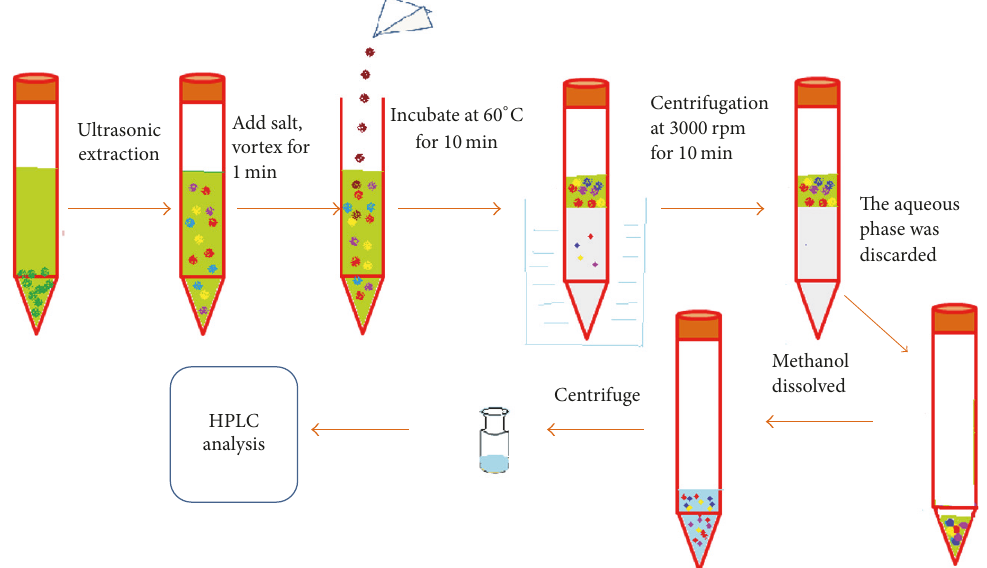
Figure 2: Schematic diagram for micellar extraction and cloud point